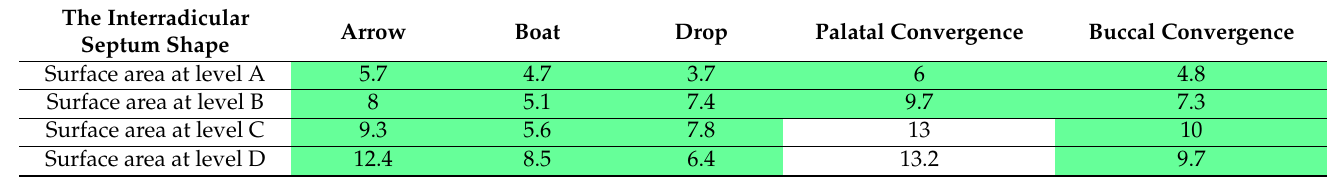
Table 5. The relationship between the average values of the IRS parameters obtained in the axial view and the implant surface area for the first maxillary molars according to the IRS shape (critical points are colored).